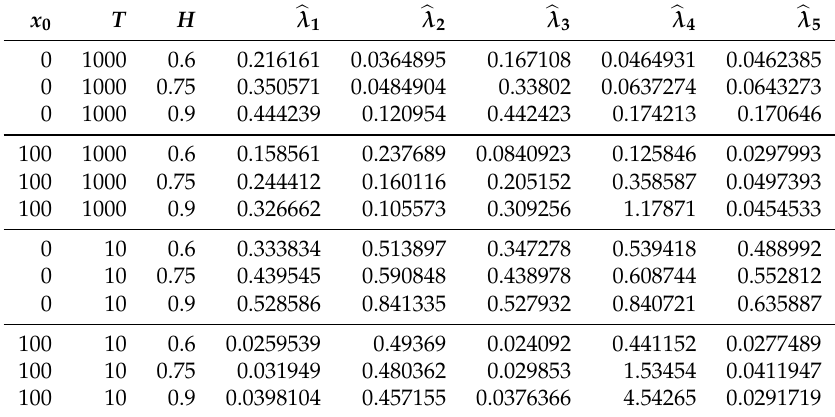
Table 1. Root mean square errors of the studied estimators calculated using 100 numerical simulations with λ =